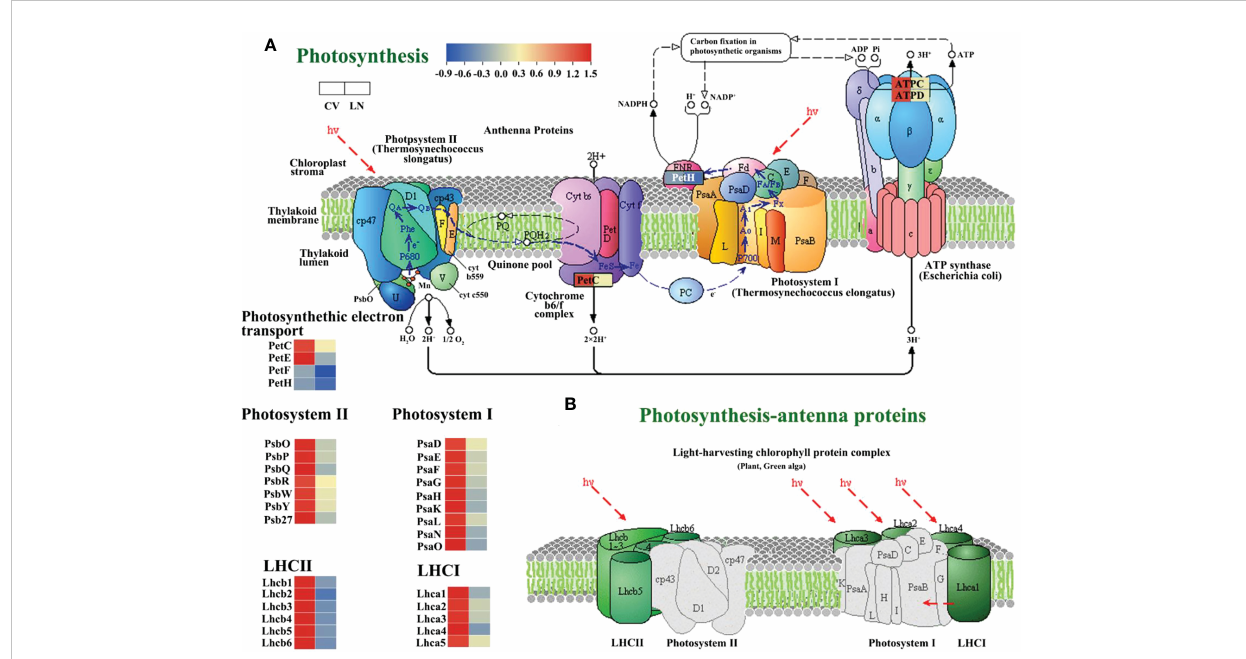
BA FIGURE 7 Signi fi cantly downregulated expression of photosynthesis-regulated genes under low N stress in sugar beet (Supplementary Table 5). (A) Photosynthetic pathway. (B) Photosynthetic antenna protein (Kanehisa et al., 2016; Kanehisa et al., FIGURE 8 DEGs in C, N, and glutathione metabolism biosynthetic pathways under LN. The red to blue colors indicate upregulated to downregulated tendencies. Same as below. DEGs, differentially expressed genes.